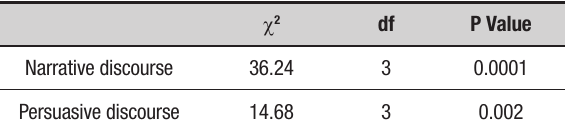
Table 5. Significance levels for macrolinguistic level (coherence) in different age